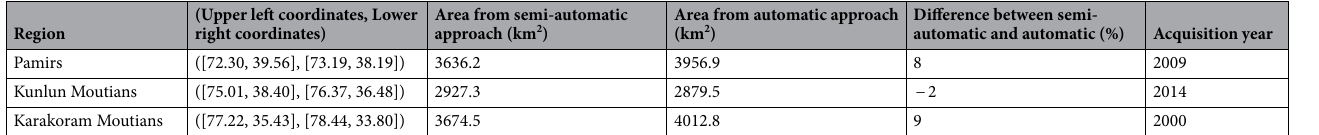
Table 4. Comparison of frequency–area distribution characteristics based on semi-automatic and automatic glacial mapping.